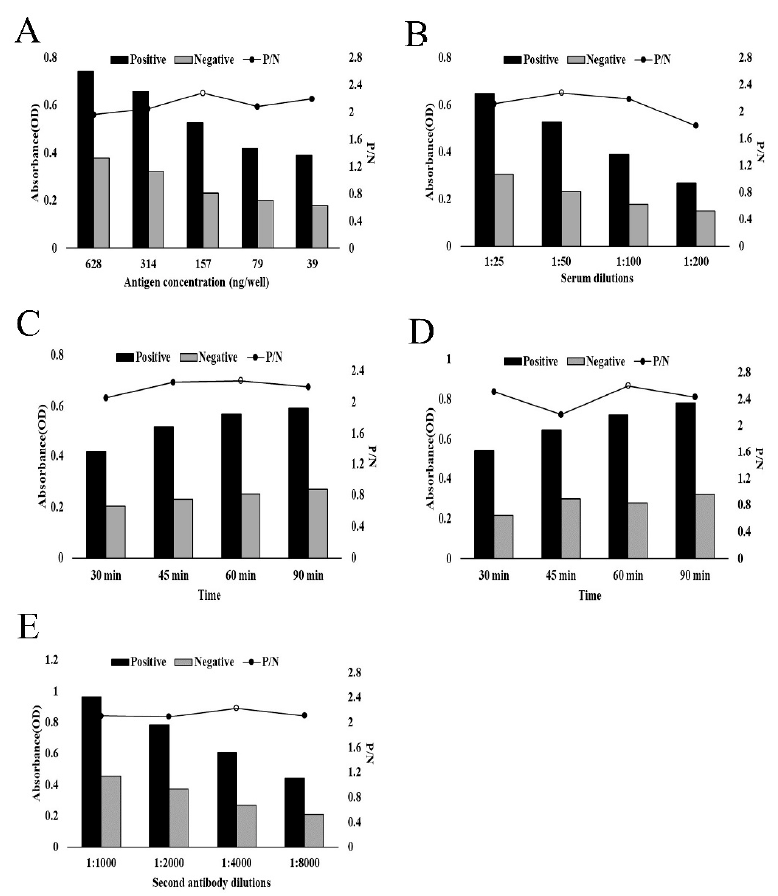
Figure 3. Optimization of indirect ELISA using rHcRas as the coating antigen. ( A ) Coating antigen (628, 314, 157, 79, and 39 ng of rHcRas per well). ( B ) Dilution of primary antibody (1:25, 1:50, 1:100, and 1:200). ( C ) Incubation time for primary antibody (30, 45, 60, and 90 min). ( D ) Incubation time for secondary antibody (30, 45, 60, and 90 min). ( E ) Dilution of second antibody (1:1000, 1:2000, 1:4000, and 1:8000).